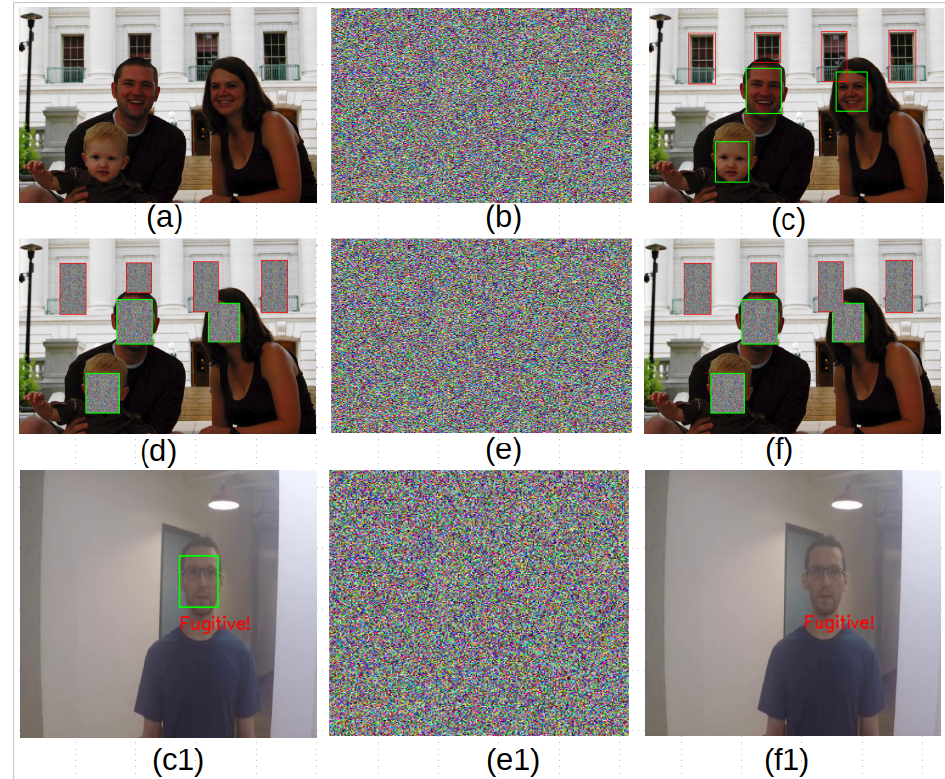
Figure 15. Window detection and denaturing: ( a ) an input image/frame [58], ( b ) input image/frame scrambled at the edge and in transit over a network, ( c ) the input image/frame with windows and faces detected at the server following unscrambling process, ( d ) the input image/frame with detected windows and faces denatured on fog/cloud server, ( e ) the whole image/frame encrypted at fog/cloud server and about to be sent to a viewing center, ( f ) the image/frame played to personnel at the viewing station following decryption, ( c1 ) a video frame with a suspected face detected at the server (video source [59]), ( e1 ) the whole frame encrypted at fog/cloud server w/o denaturing the face, and ( f1 ) is the frame containing clear face (with a “Fugitive!” text mark) of suspect displayed at viewing center following